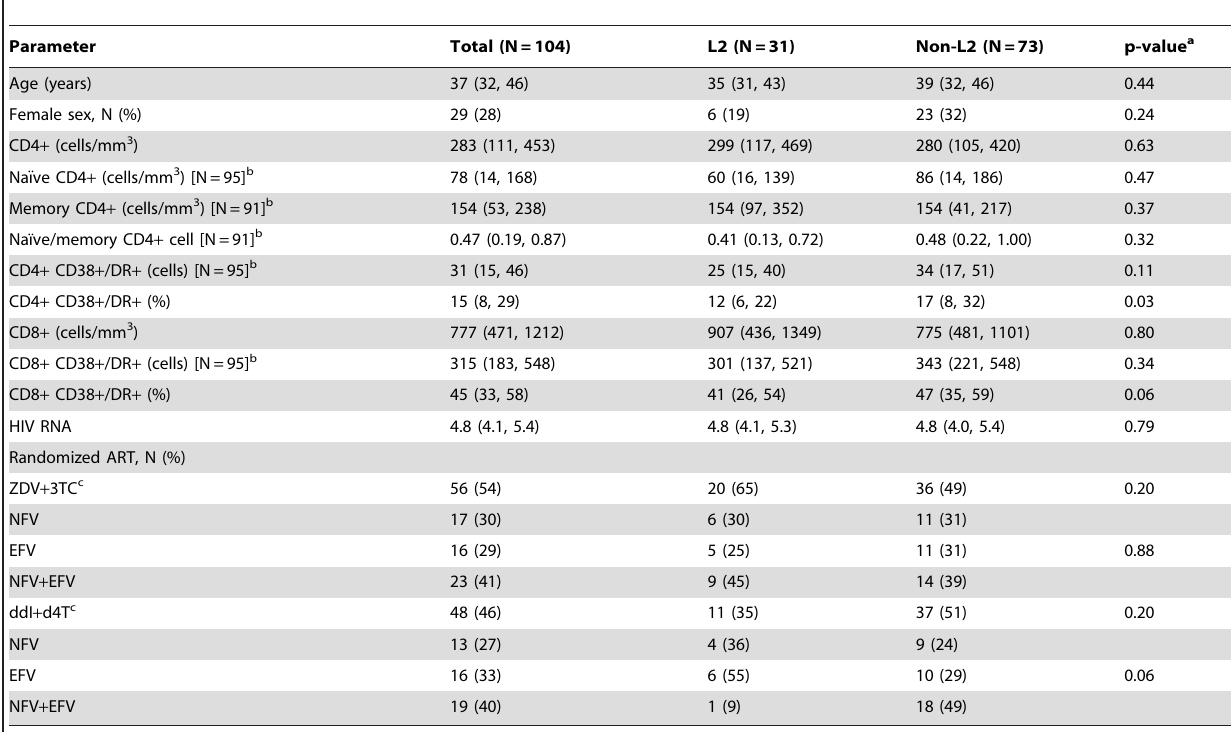
Table 1. Baseline demographic data, T cell parameters, HIV RNA, and ART randomization arms among the black, non-Hispanic ACTG 384 population with baseline CD4 activation markers and 48 week HIV RNA , 400 copies/mL, total and by African L2 and non-L2 mtDNA